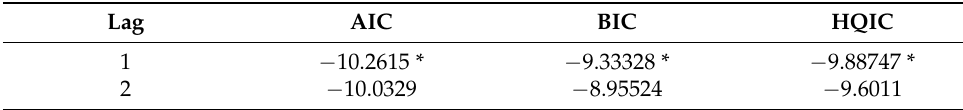
Table 6. Results of PVAR model optimal lag order